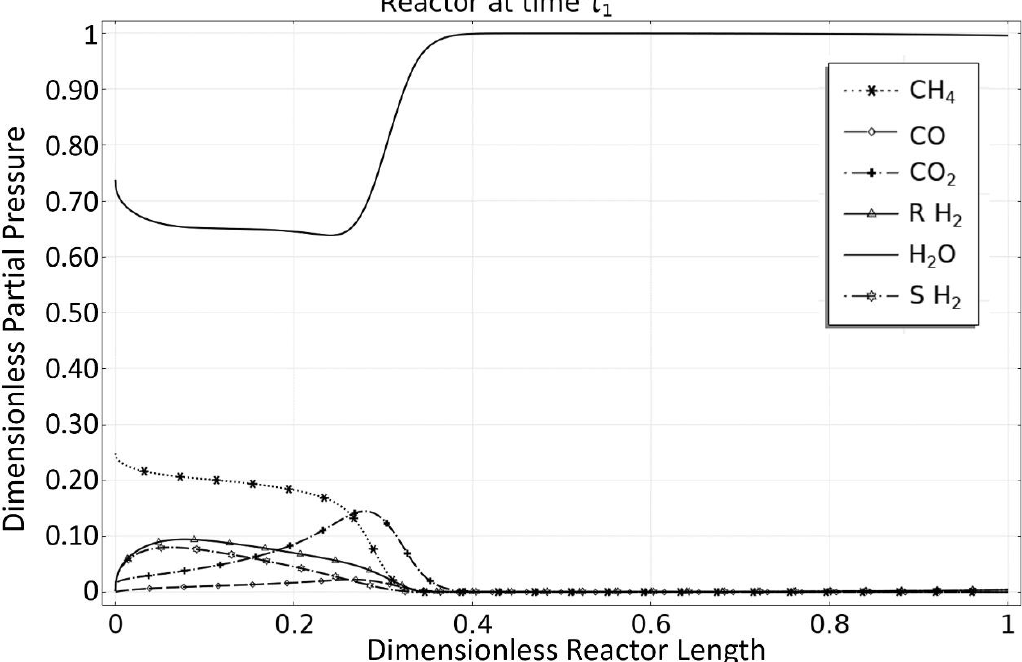
Figure 13. Species’ dimensionless partial pressure axial length profile during cycle 3 at the end of OM 1 for Da = 4, Θ = 50.